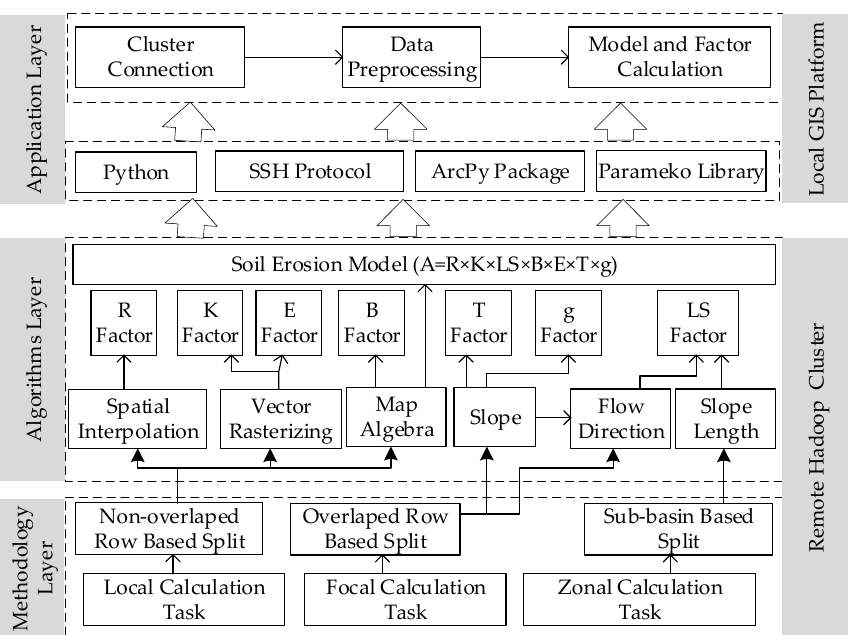
Figure 1. Overview of parallel computing tools for the soil erosion model.